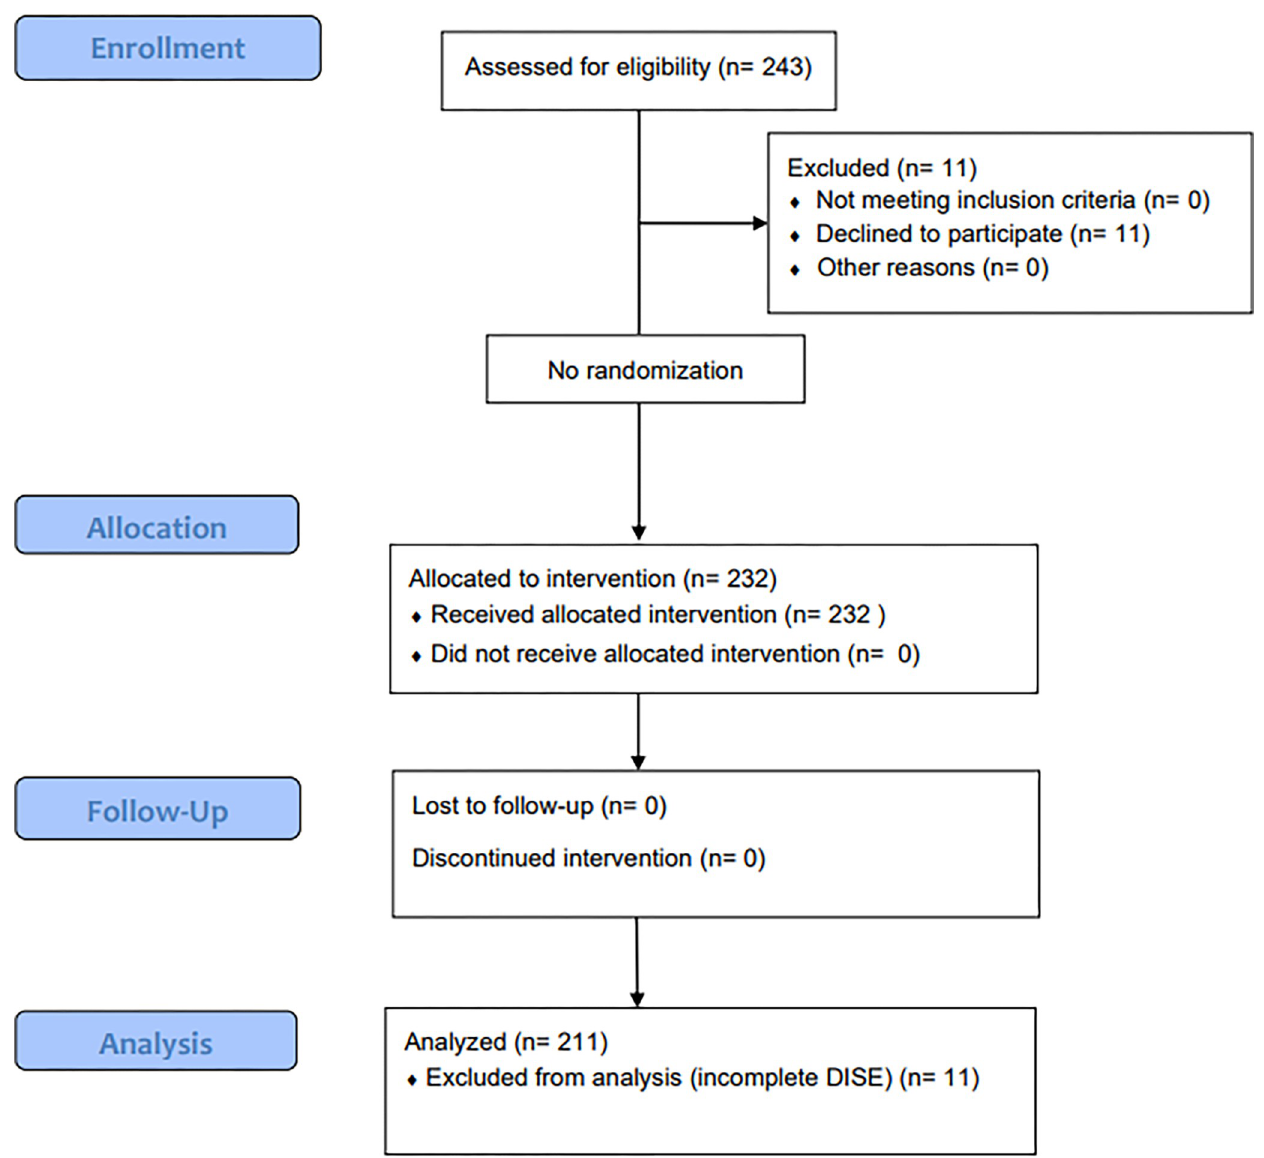
Fig 1. Flow chart of patient deposition. In total, 243 patients underwent initial screening for the study, and 221 patients underwent DISE with head rotation maneuvers. Patients were divided into the positional sleep apnea (POSA, n = 91) group (supine sleep position for � 30 min) and the non-positional sleep apnea (non-POSA, n = 76) group (non-supine sleep position for � 30 min). Patients who slept only in the supine position or only in the lateral position � 30 min were excluded from the subgroup analysis (n = 54). according to the VOTE classification system at four different levels of the collapsible segment: the velum (palate), oropharyngeal lateral walls, tongue base, and epiglottis [21]. The velum, oropharyngeal lateral wall, and tongue structures were scored according to the degree of col- lapsibility: 0 = no obstruction (collapse less than 50%), 1 = partial (collapse between 50 − 75%), or 2 = complete (collapse > 75%). The epiglottis was scored differently according to previous studies: 0 = no obstruction (collapse less than 50%), 1 = partial (collapse between < 100%), or 2 = complete (collapse = 100%) [22, 23].